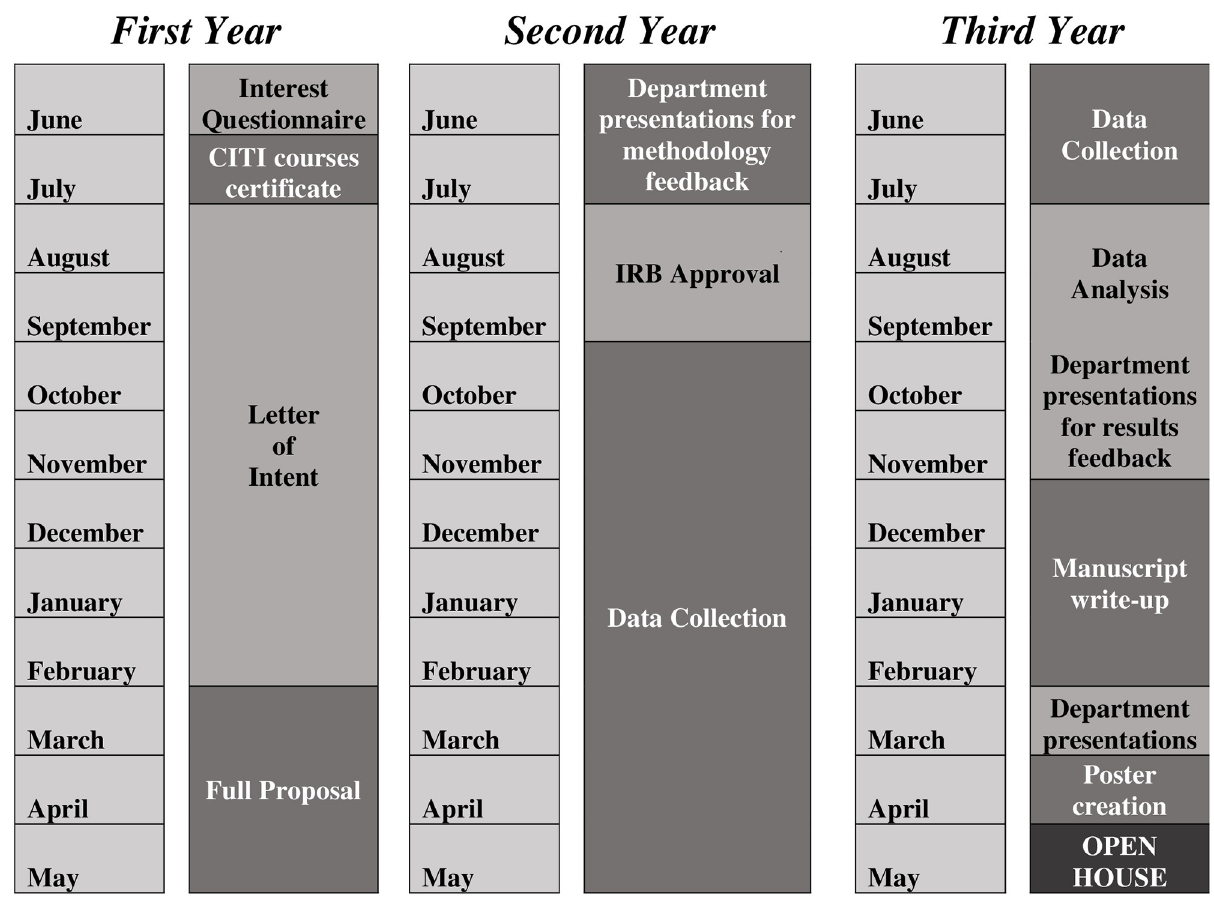
Fig 1. Timeline for residents (in a 3-year residency) participating in the FRRP to complete their projects.